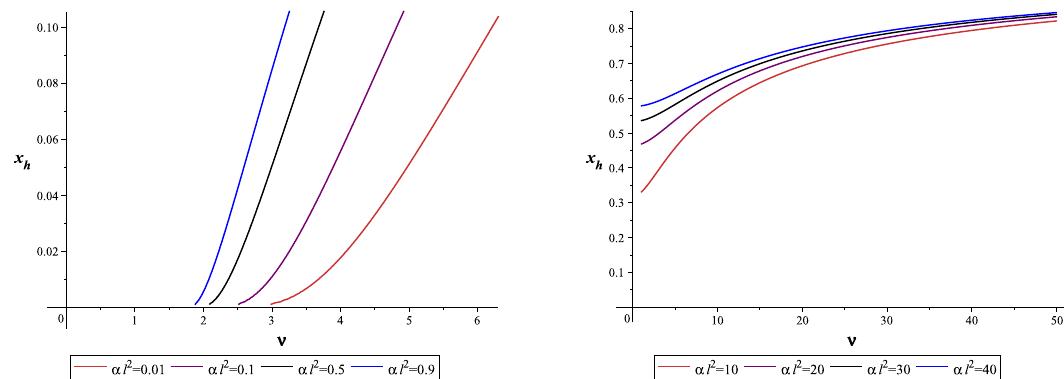
Figure 1 . We plot L ( x h ; (cid:23) ) for di(cid:11)erent (cid:12)xed values of x h (left) and (cid:23) (right).